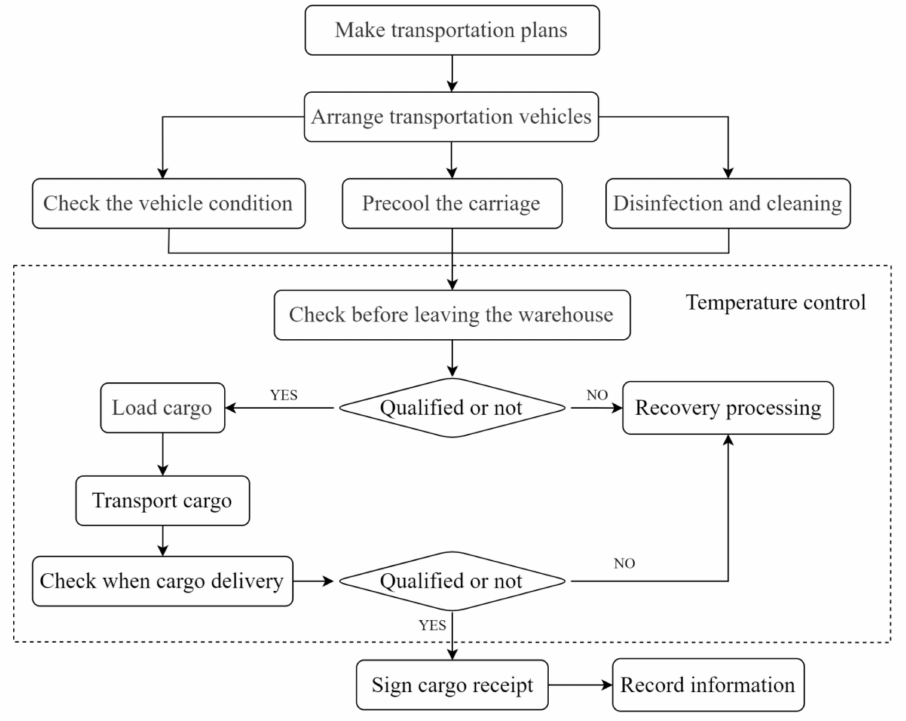
Figure 4. Flow chart of the logistics process from port to